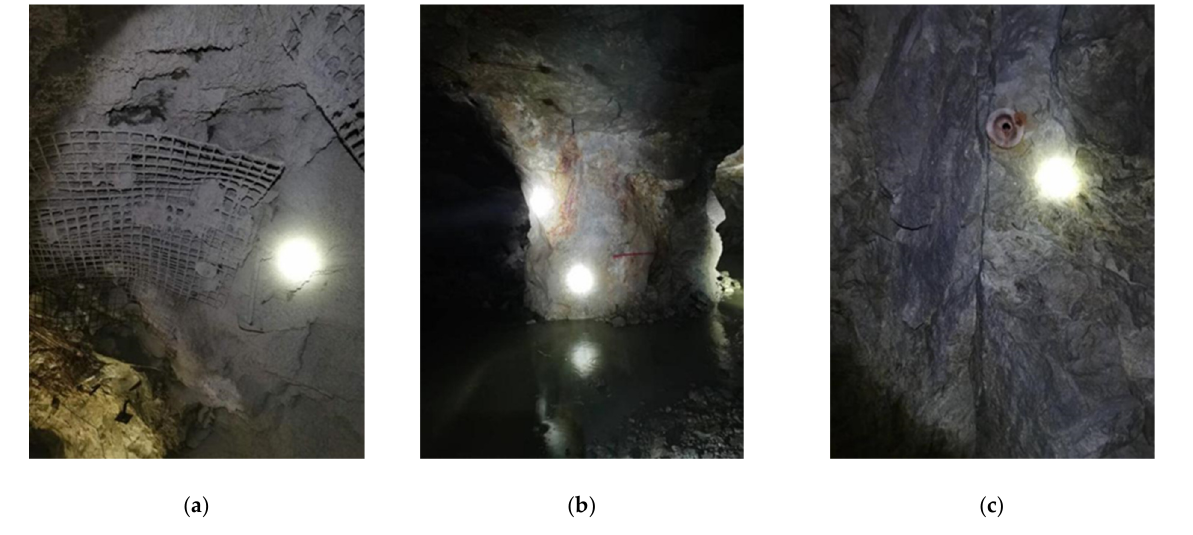
Figure 13. The rockburst disasters in Sanshandao Gold Mine: ( a ) Strainburst in roof; ( b ) Pillar burst; ( c ) Slabbing in sidewall.